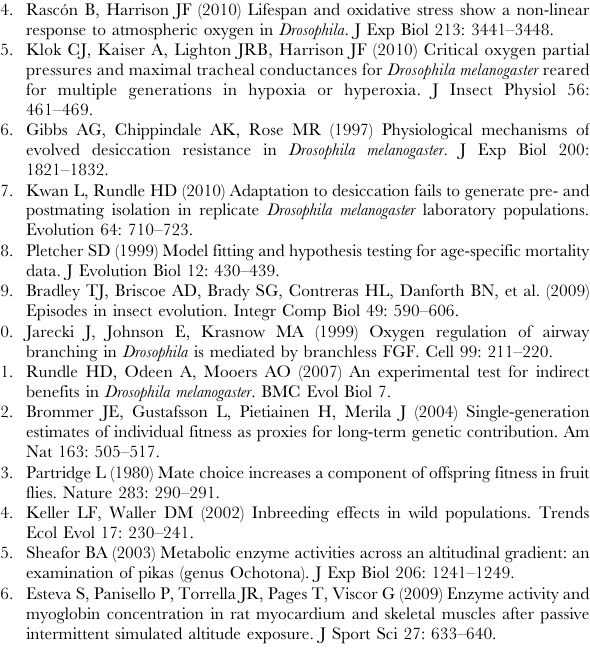
Figure S2 Mortality under prolonged desiccation stress as measured at generation 15(10 hyperoxia). Male (solid)